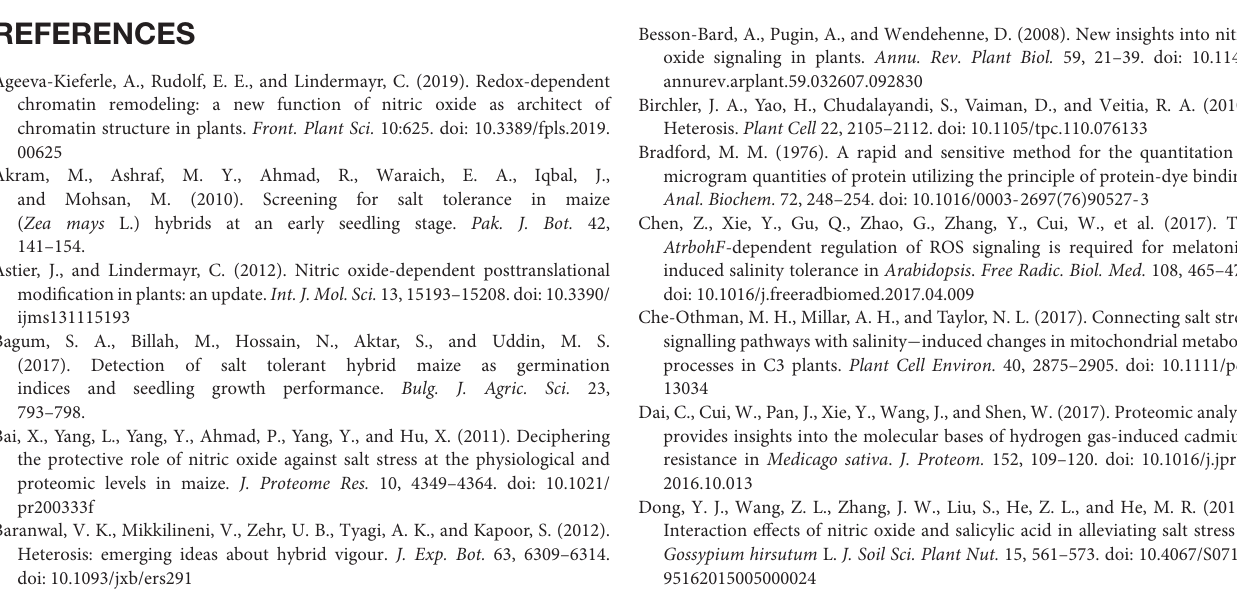
Supplementary Table 1 | The sequences of primers for qPCR. Supplementary Table 2 | Total number of identified